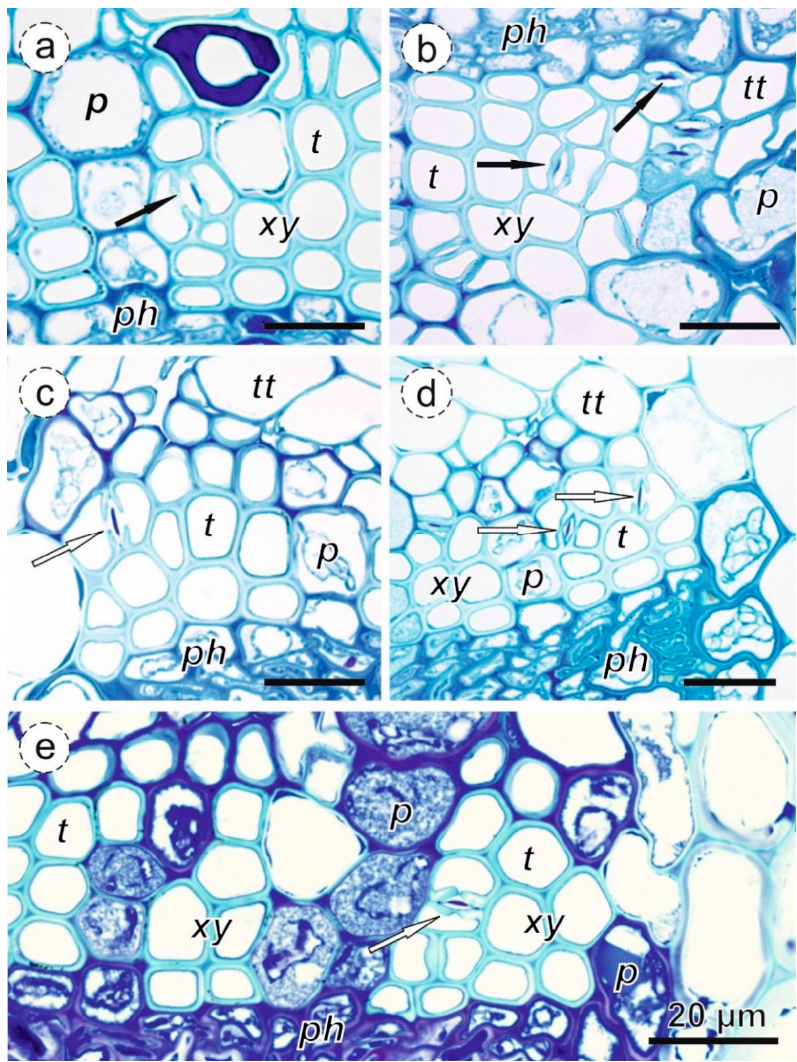
Figure 4. Pit aspiration in the xylem of the needle vascular bundles at different dates. ( a , b ) 24 November 2010, ( c , d ) 15 June 2011, and ( e ) 10 September 2011; p, parenchyma cell; ph, phloem; t, tracheid; tt, transfusion tracheid; xy, xylem; open arrows point at open pits, closed arrows at aspirated pits, reference bars = 20 µm.